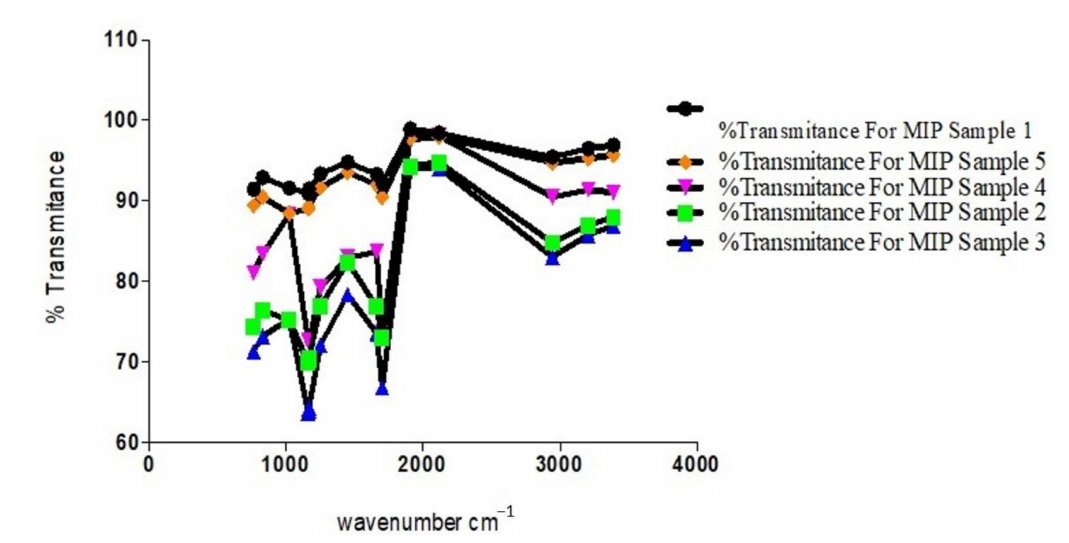
Figure 9. Plot of transmittance against wavenumbers of prominent peaks of MIP samples.